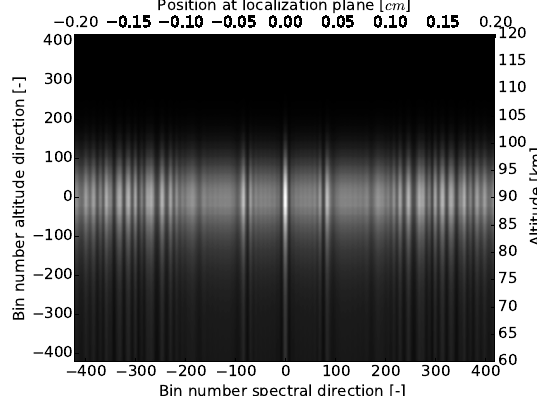
Table 1. Summary of optics and filter properties.